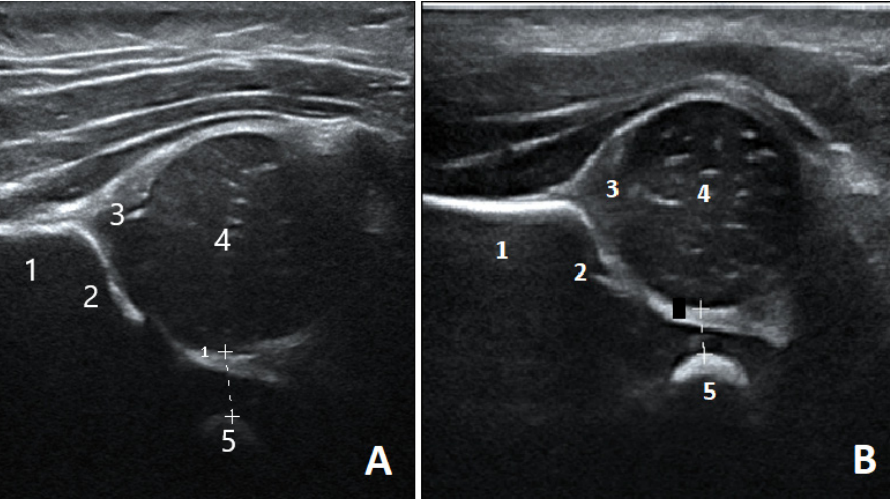
Figure 1. Ultrasound image of a two different newborn hips obtained by a musculoskeletal radiologist ( A ) and a midwife ( B ) depicting the quality criteria for the PFD measurement: A horizontal ilium (1), the bony (2) and cartilaginous (3) acetabular roof, the femoral head (4) and the lateral epiphysis of the pubic bone (5). The PFD is the minimal distance between the medial femoral epiphysis and the pubic bone (dotted line). PFD = Pubo-femoral distance.